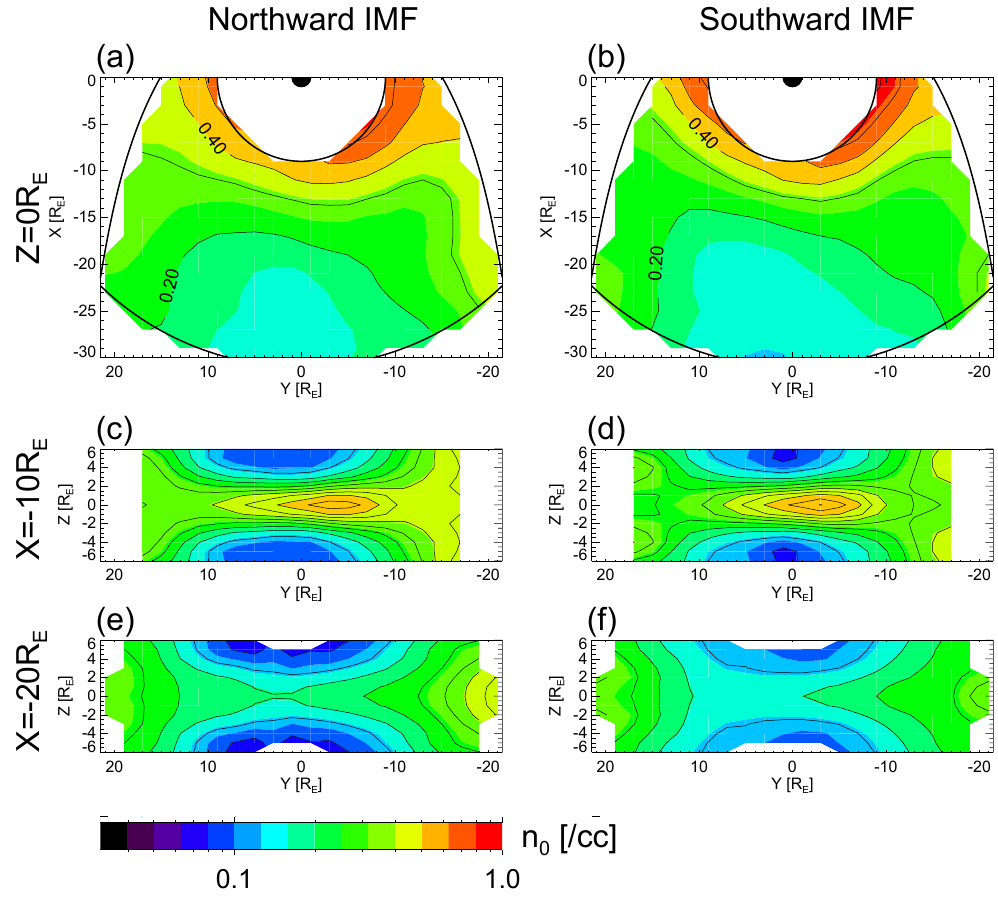
Fig. 2. Distribution of plasma number density n 0 for the northward and southward IMF conditions. Format is the same as Fig.